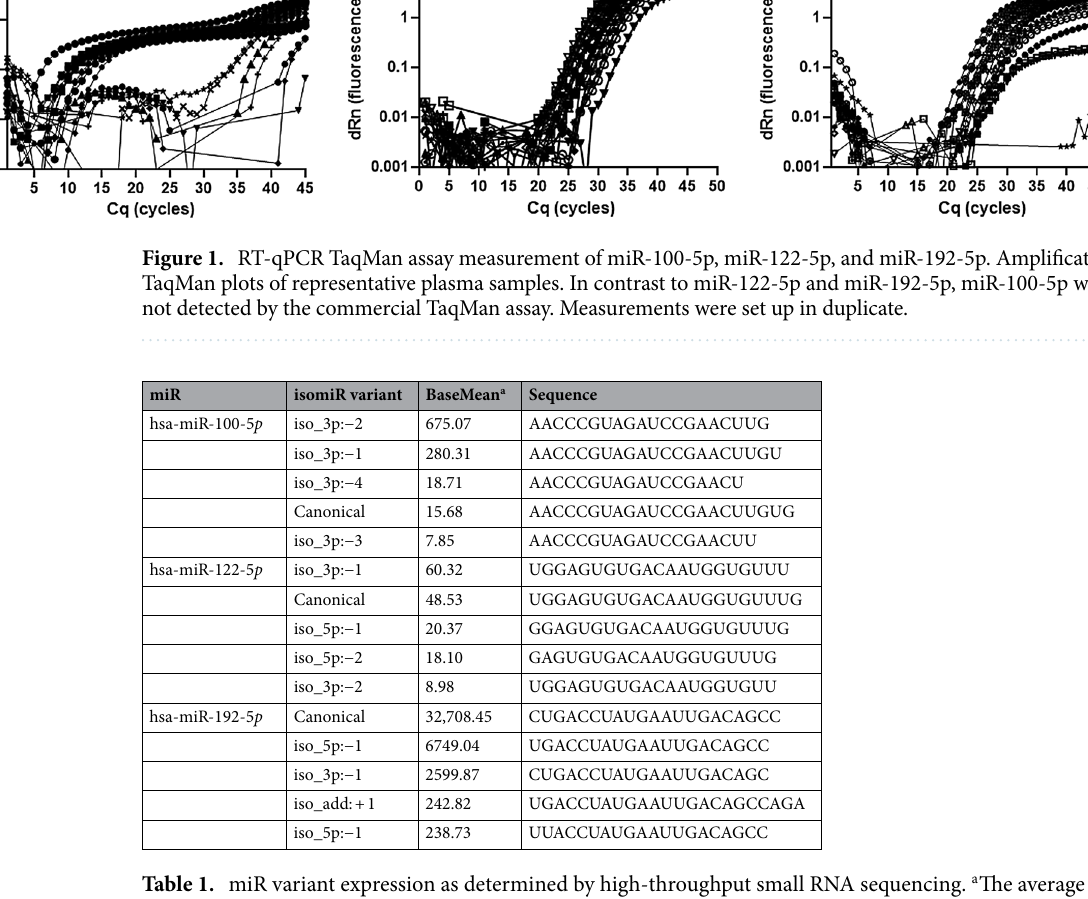
Table 1. miR variant expression as determined by high-throughput small RNA sequencing. a The average of the normalised count values according to DeSeq2 as described in (15).